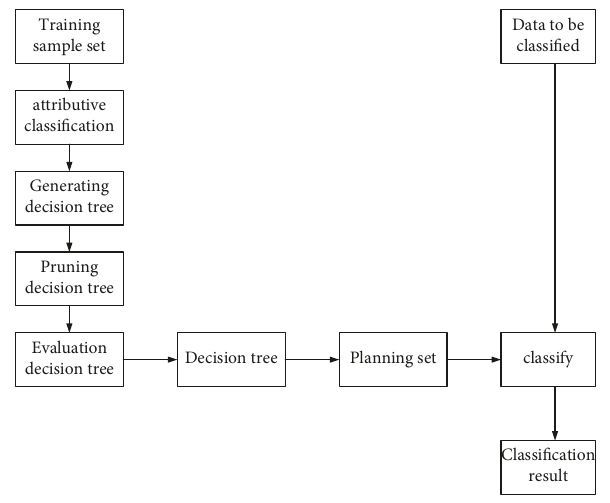
Figure 2: Classification process of decision tree.